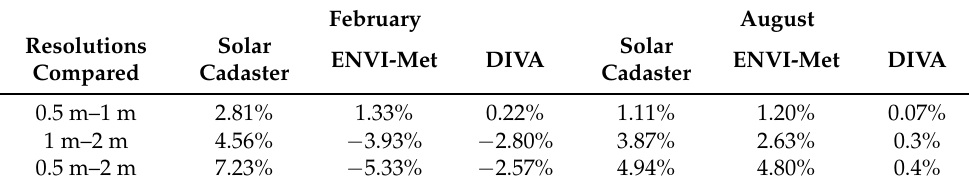
Table 2. Divergence of the cumulative irradiation according to the resolution of the mesh. February